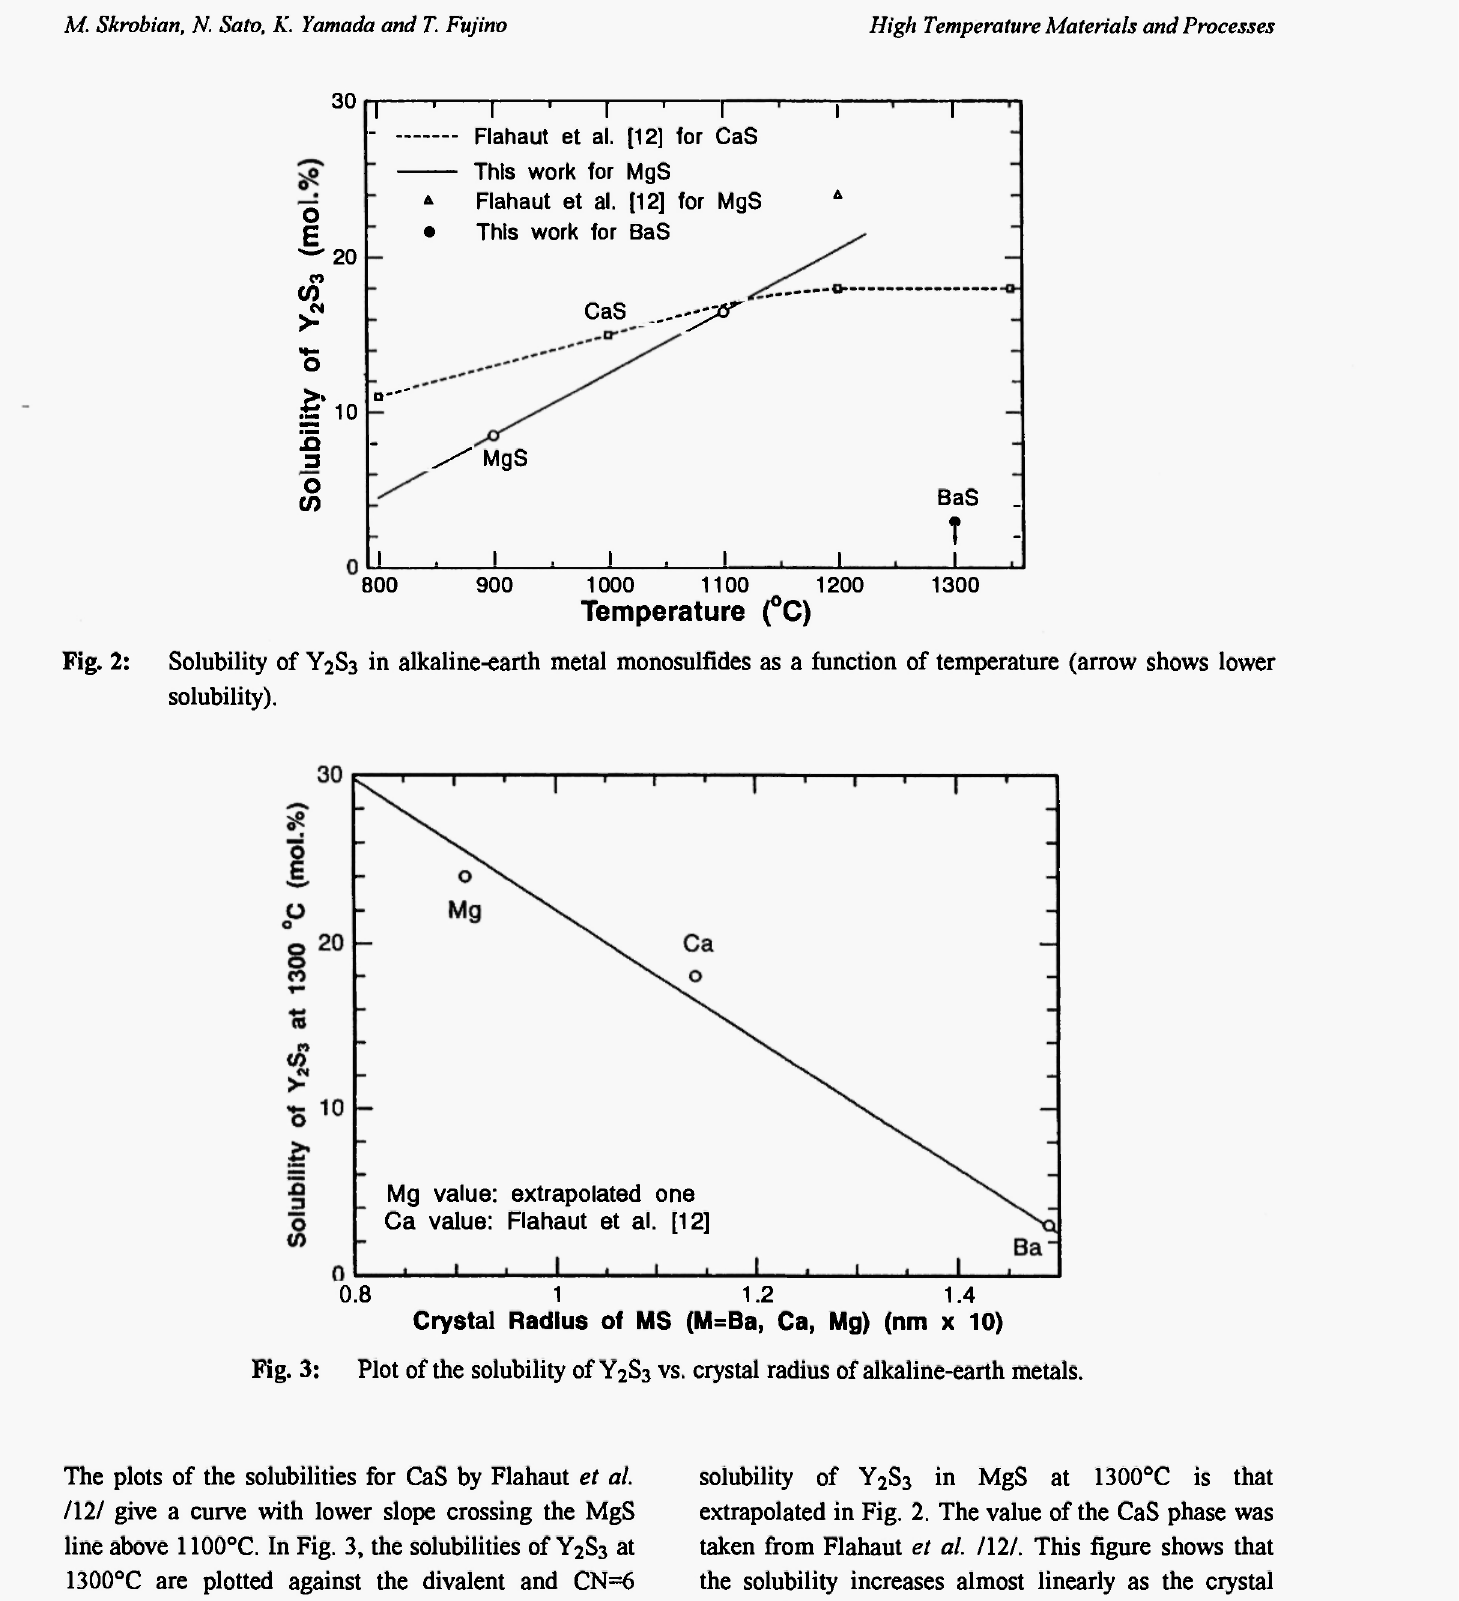
solubility of Y S in MgS at 1300°C is that 2 3 extrapolated in Fig. 2. The value of the CaS phase was S at taken from Flahaut et al. /12/. This figure shows that 2 3 the solubility increases almost linearly as the crystal radius of the alkaline-earth metals